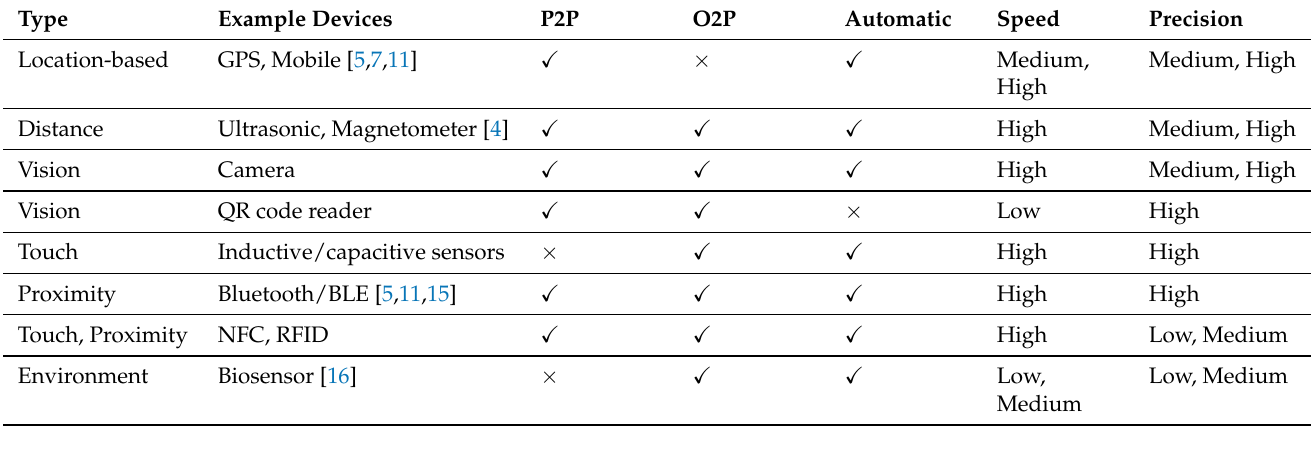
Table 1. Types of sensing technologies for IoT-CTS.